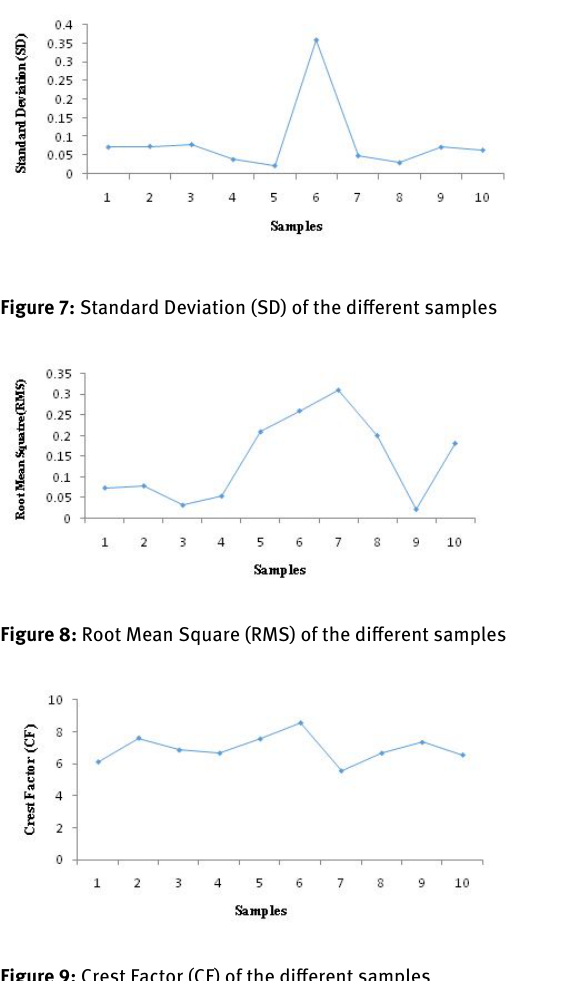
A healthy or unhealthy condition is lead by the ma- chine operation status after detecting by the characteris-